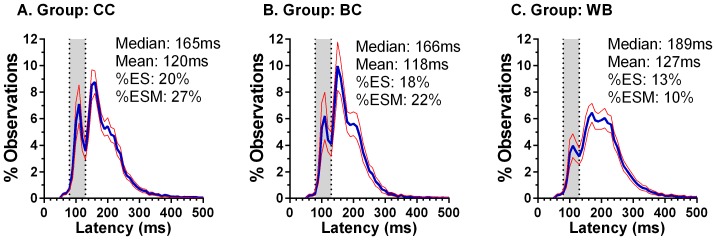
Average (mean±95%CI) percentage latency distribution histograms for the three participant groups for overlap data.Bin width = 10 ms. Mean and median latency for these distributions are also shown, along with the percentage of observations falling in the ES range (%ES; range 80–130 ms, shown by vertical dotted lines), and the proportion of ESM participants in that group (%ESM).